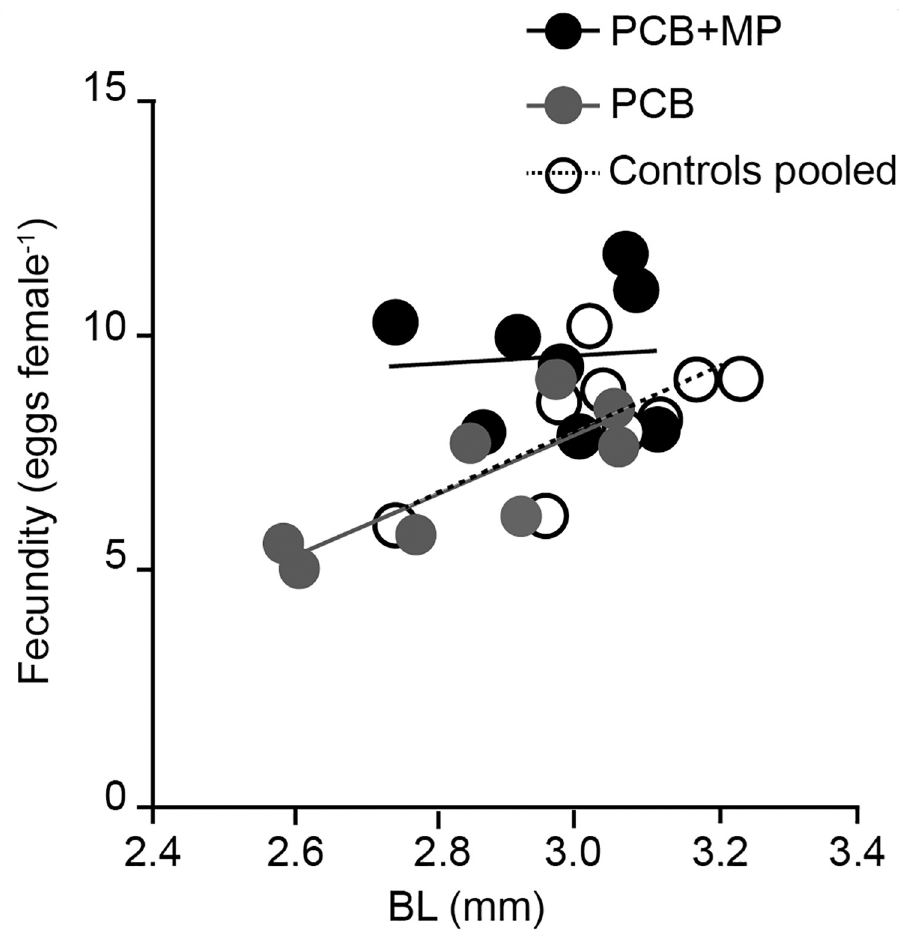
Fig 4. Treatment-specific relationships between fecundity and body length in D . magna . Whereas the overall relationship was significant, the group-specific slope was significantly different from zero only in the PCB group (R 2 = 0.7, p < 0.02) and in the pooled controls (R 2 = 0.5, p <